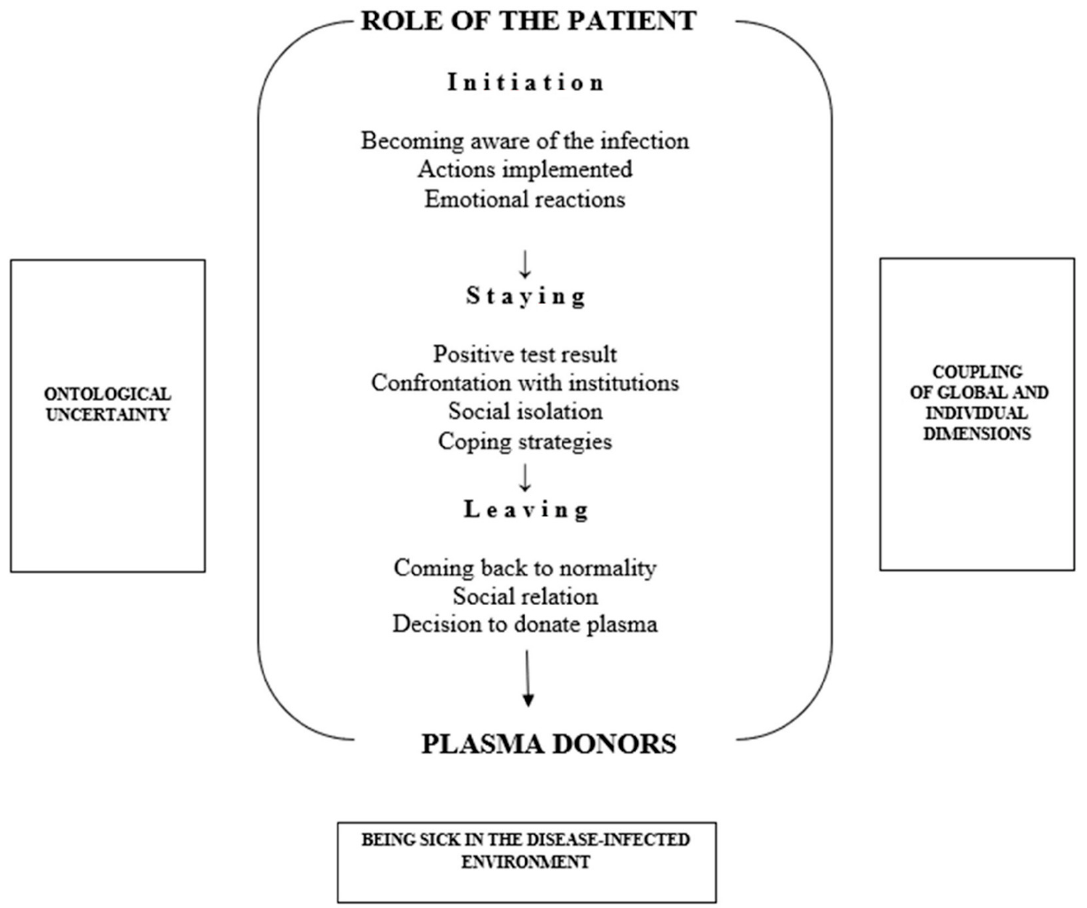
Figure 1. Map of experiences if COVID-19 convalescents.